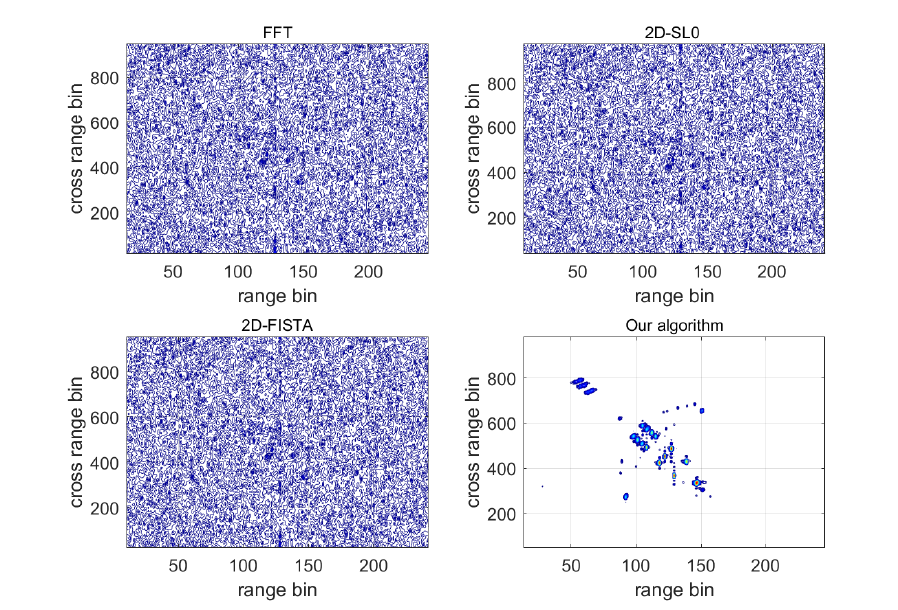
Figure 8. Imaging result with the percentage of outliers being